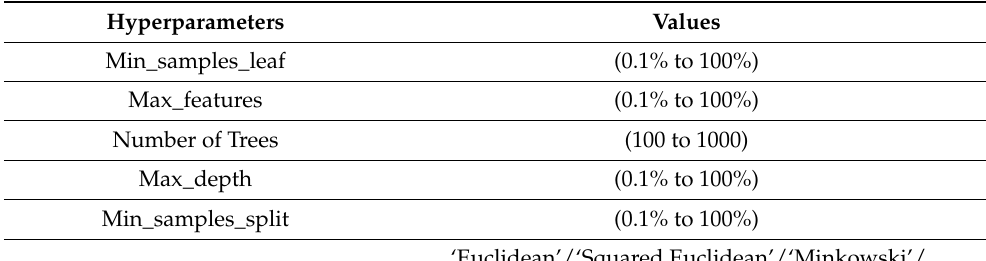
Figure 5. Input Features for Point Estimation. Table 2. The RF Hyper-Parameters ranges are used for searching the optimum values.